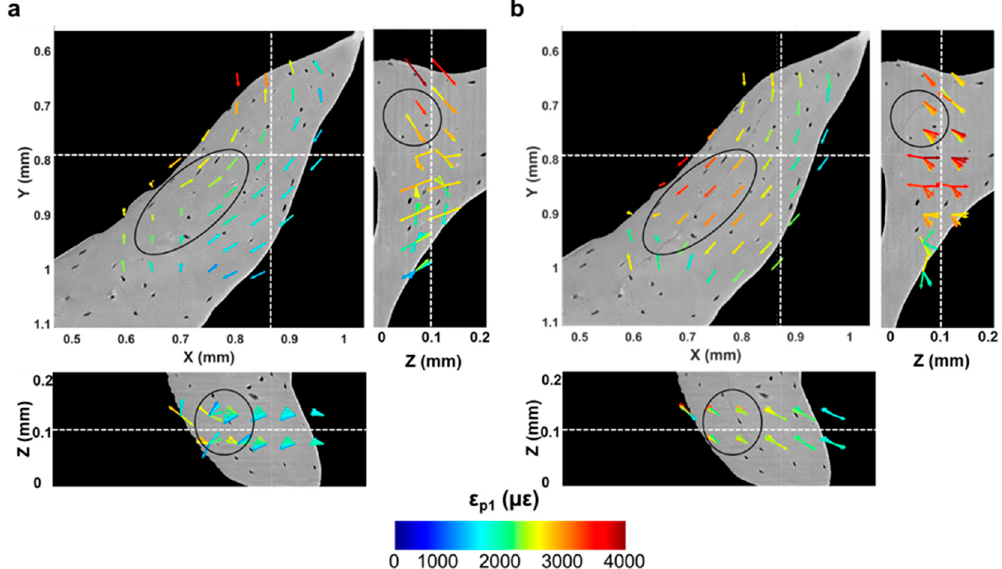
Figure 9. DVC-computed first principal strain ( ε p1 ) through the region of interest analysed around the microcracked area ( a ) before (fourth tomogram) and ( b ) after cracking was visible (fifth tomogram). Vectors indicate first principal strain directions in each subvolume. Oval regions highlight damaged areas of bone tissue, which correspond to high orientation changes in the principal strain direction before and after cracking. Vector lengths are identical, and the colour code refer to the ε p1 magnitude.